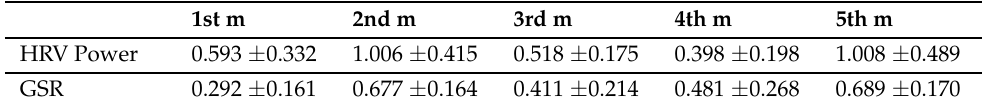
Table 7. Mean and standard deviation of experiment 2.